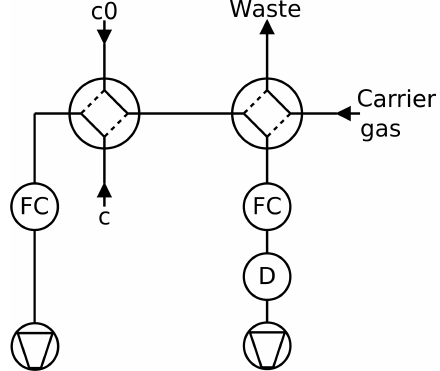
Figure 3. Twin tube method, continuous mode: a partial current is sucked through the detector D by a mass flow controller FC. A sec- ond four-port valve enables switching the detector to pure carrier gas to record the baseline.